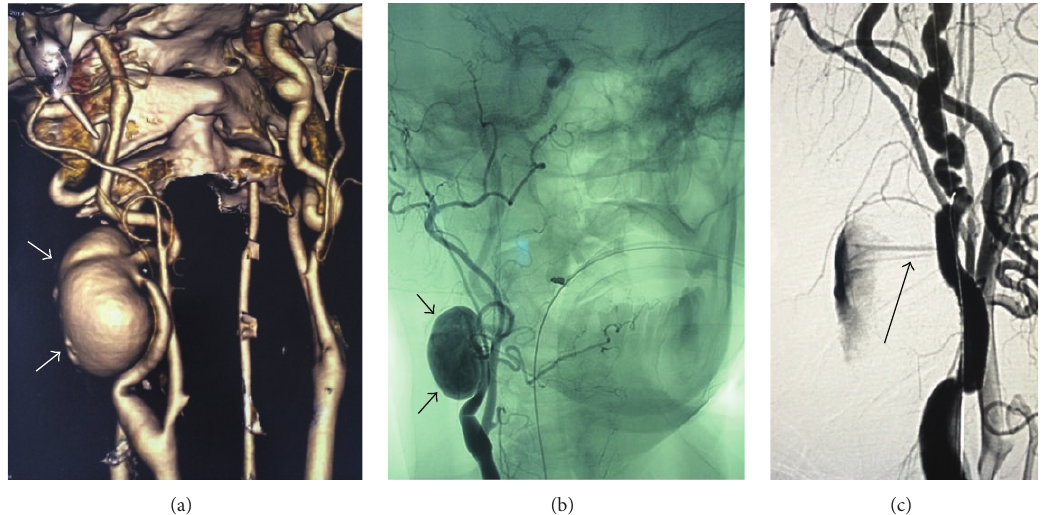
Figure 1: (a) Preoperative CT, the arrow points to the aneurysm; (b) intraoperative angiography, the arrow points to the aneurysm; (c) intraoperative angiography after first stent graft deployment, the arrow points to the leak.